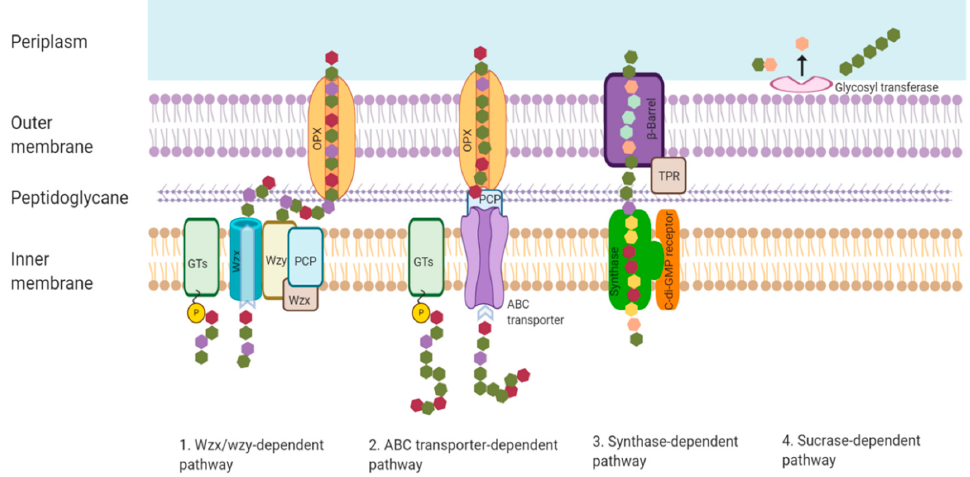
Figure 3. Microbial pathways for EPS synthesis. GTs: glycosyltransferases; PCP: polysaccharide co-polymerase; OPX: outer membrane polysaccharide export; TPR: tetratricopeptide repeat pro- tein.